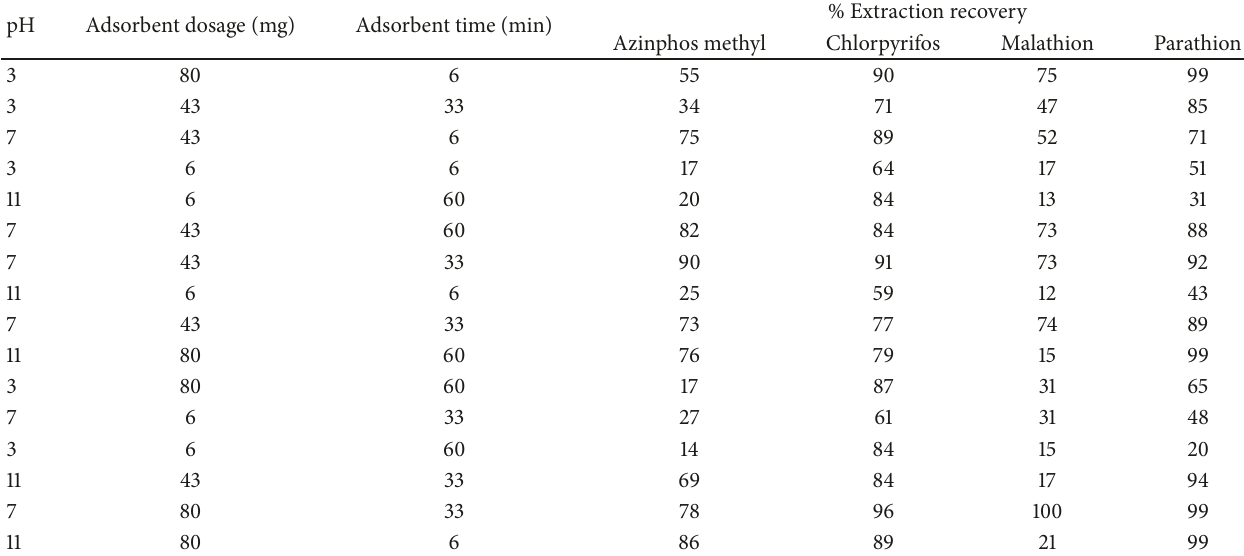
Table 1: Percentage extraction recovery of azinphos methyl, chlorpyrifos, parathion, and malathion using Fe 3 O 4 @SiO 2 -MWCNT adsorbent. pH Adsorbent dosage